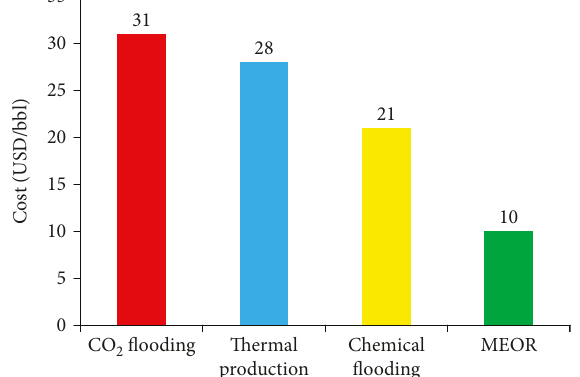
Figure 4: MEOR diagram [6].